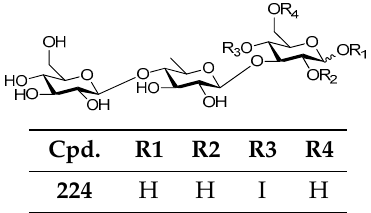
Figure 39. Structure of compound 224 .